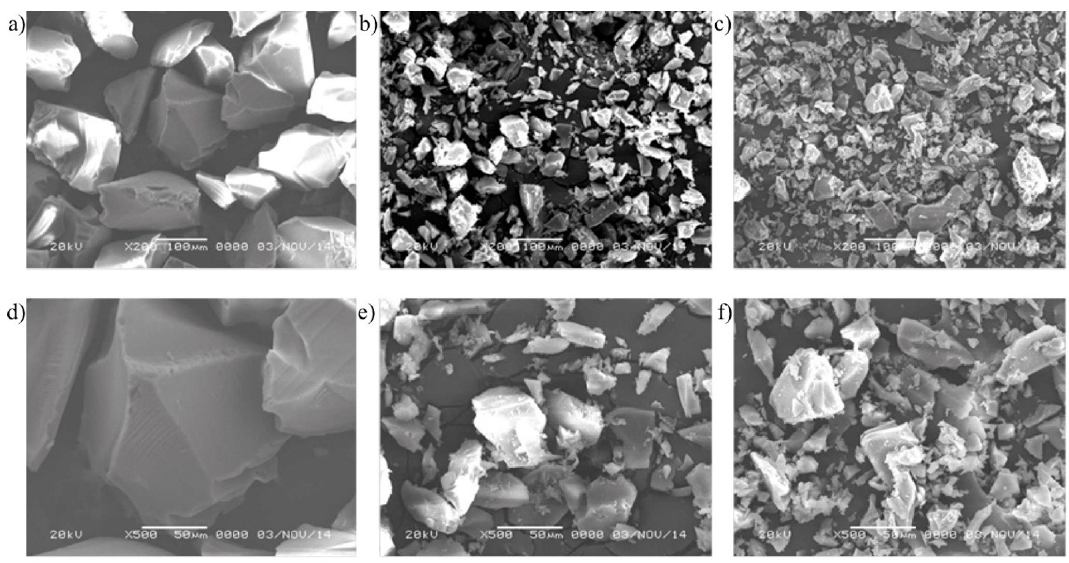
Figure 6. SEM images of SiO 2 ( a , d , g ), VTMSO-SiO 2 ( b , e , h ), and Q/VTMSO-SiO 2 ( c , f , i ) with different magnifications. 3.6. Arsenic Retention Properties of Q/VTMSO-SiO 2 In Figure 7, the results of affinity assays between Q/VTMSO-SiO 2 and model arsenic solution are shown. In elutions 1 and 2, the cartridge was able to capture all the arsenic present in the model solution. In the third elution, the capture capacity of the cartridge decreased to 97.7%. The fourth elution showed a capture capacity of 74.9%. In the fifth elution, the cartridge capture capacities fell to 48.2%. Finally, in the sixth elution, the cartridge capture capacities were only 19%. Considering these results, 1 g of Q/VTMSO-SiO 2 could treat up to 320 mL of 0.1 mg·mL − 1 arsenic solution, capturing the total amount of arsenic. If we want to decrease the concentration of arsenic to a half value, we can treat up to 800 mL of 0.1 mg·mL − 1 arsenic solution. Scaling these results, if we use a filter filled with 1 kg of Q/VTMSO-SiO 2 , we can treat 320 L of water with arsenic concentration